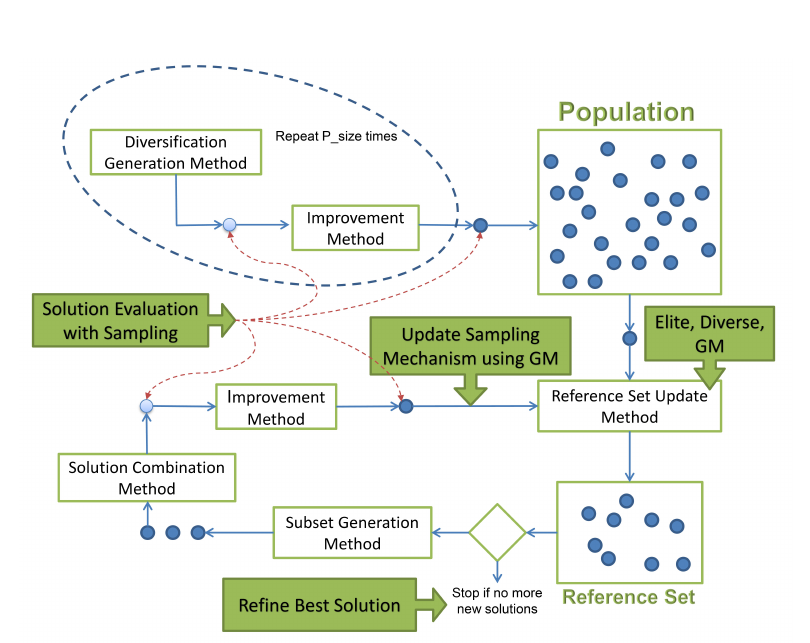
Figure 7. The structure of the DSSSP